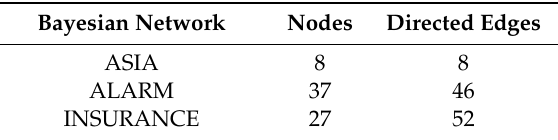
Table 2. Three Bayesian